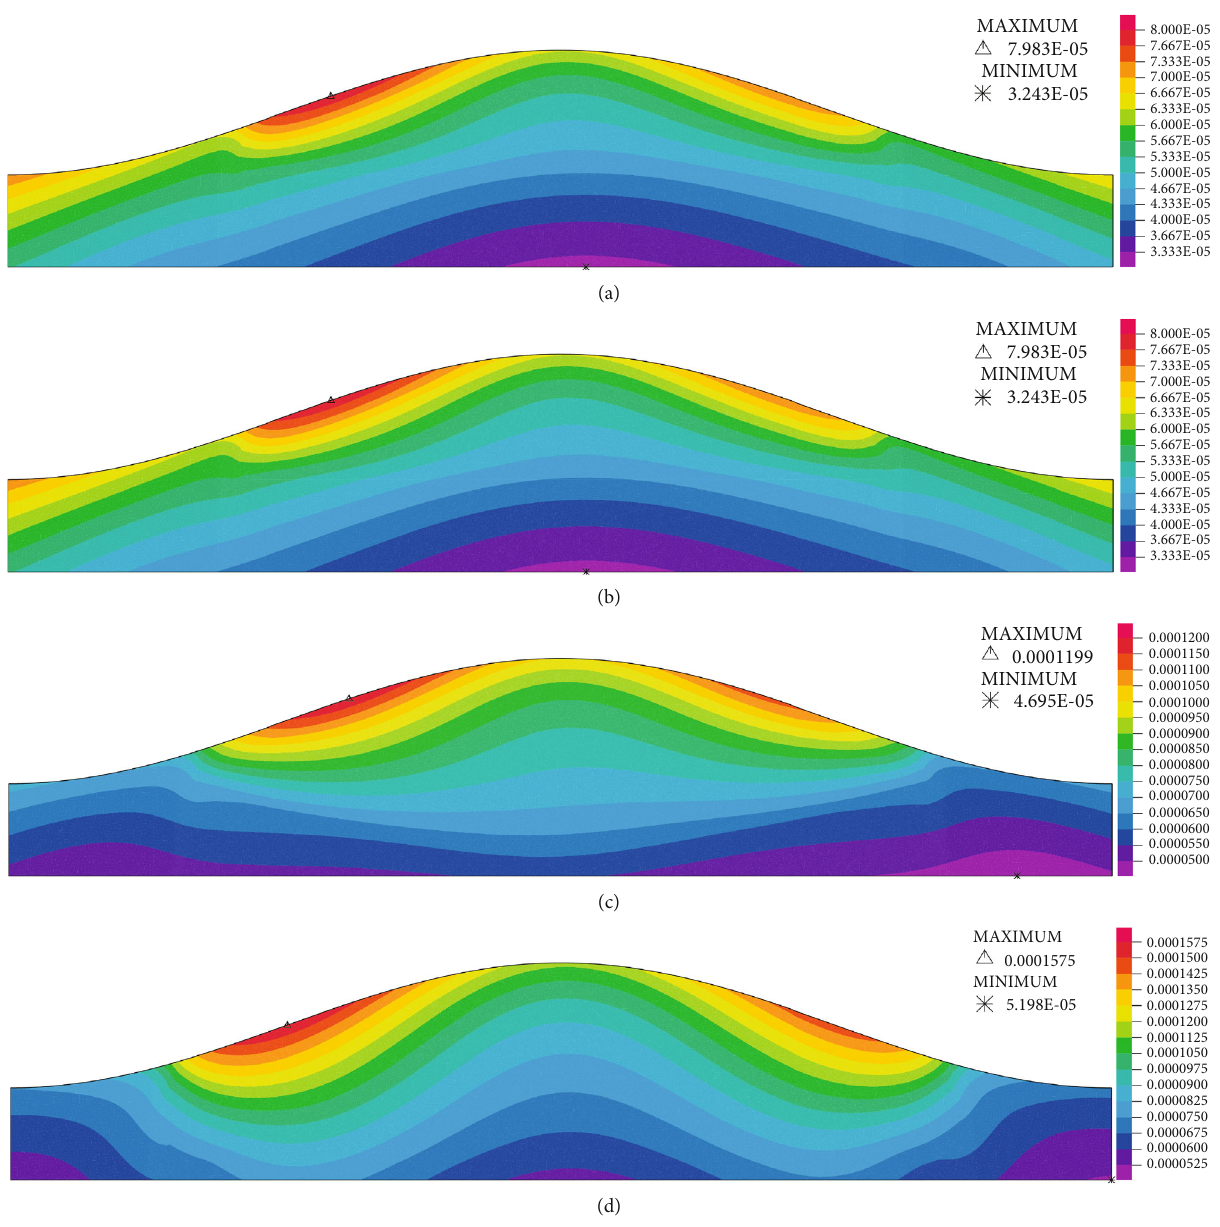
Figure 7: Wall displacement (m) contours for (a) G1, (b) G2, (c) G3, and (d) G4 models with 70% severity. Table 5: The radial displacement in the stenosis throat at peak fl ow